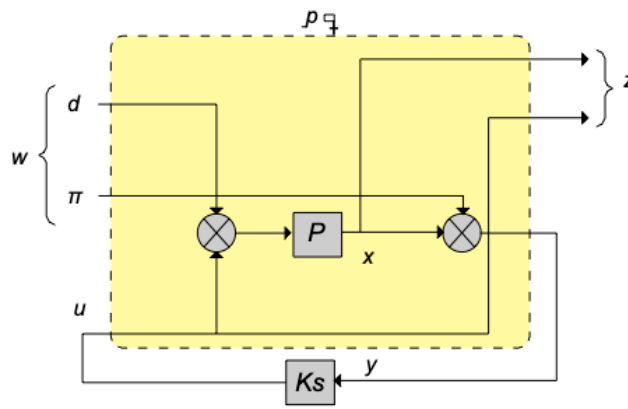
Figure 3. Two-port detailed graph.